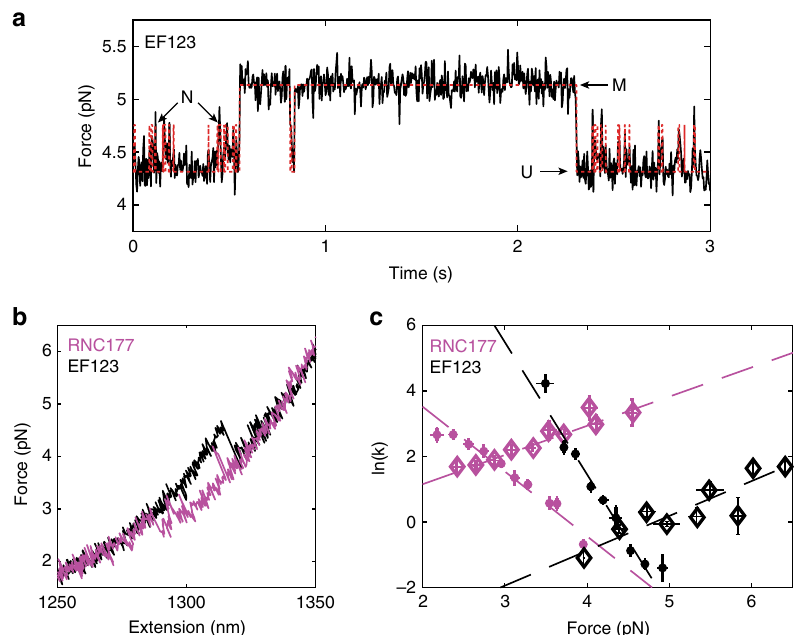
Fig. 3 The misfolded state has altered kinetics on the ribosome. a Passive data for EF123 shows a short-lived state (N domain) in between the two more distinct states (U, unfolded, at lowest force and M, misfolded, at the highest force). The red dashed line is the HMM fi t. b Overlaying the refolding curves from RNC177 (magenta) and EF123 (black) shows they are the same size transition, although EF123 has short-lived N transitions prior to full misfolding. c The folding kinetics of RNC177 are slower and the unfolding kinetics are faster relative to EF123. Diamonds: unfolding rates, circles: folding rates. Error bars are standard error (SE). See Supplementary Table 2 for the fi ts from the Bell plot shown. RNC177: n = 10 molecules, 111 rate measurements. EF123 (unfolding): n = 14 molecules, 97 rate measurements. EF123 (folding): n = 13 molecules, 88 rate measurements. Source data are provided as a Source Data fi